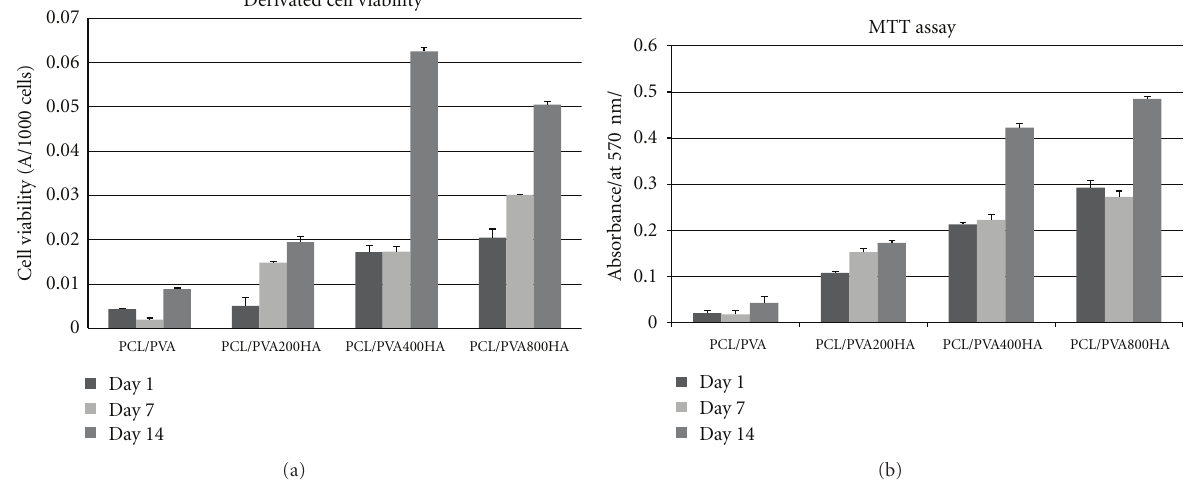
Figure 2: Cell metabolic activity and viability. Metabolic activity of viable MSCs was detected by MTT assay on day 1, 7, and 14 (mean ± standard deviation). Results of MTT assay for PCL/PVA, PCL/PVA200HA, PCL/PVA400HA, and PCL/PVA800HA samples (a). Cell viability calculated as derivation of absorbance values from MTT assay to cell counts determined by PicoGreen assay (b).